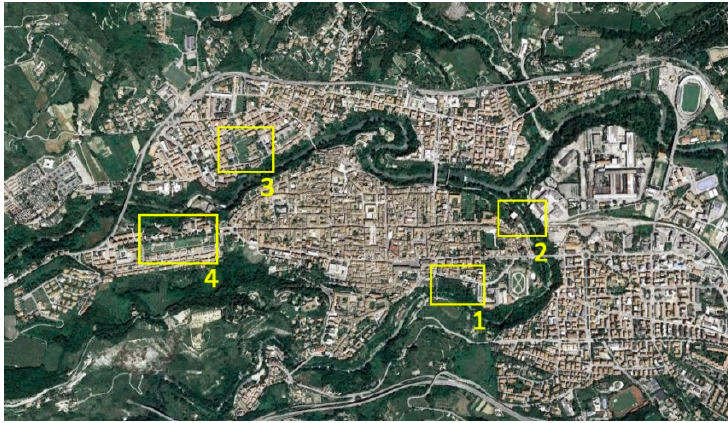
Figure 1. The city of Ascoli Piceno—Case studies: no. 1 Bus station, no. 2 Ex Società Impianti Materiali Elettrici (S.I.M.E.), no. 3 Porta Solestà, no. 4 Ex Tiro a Segno.